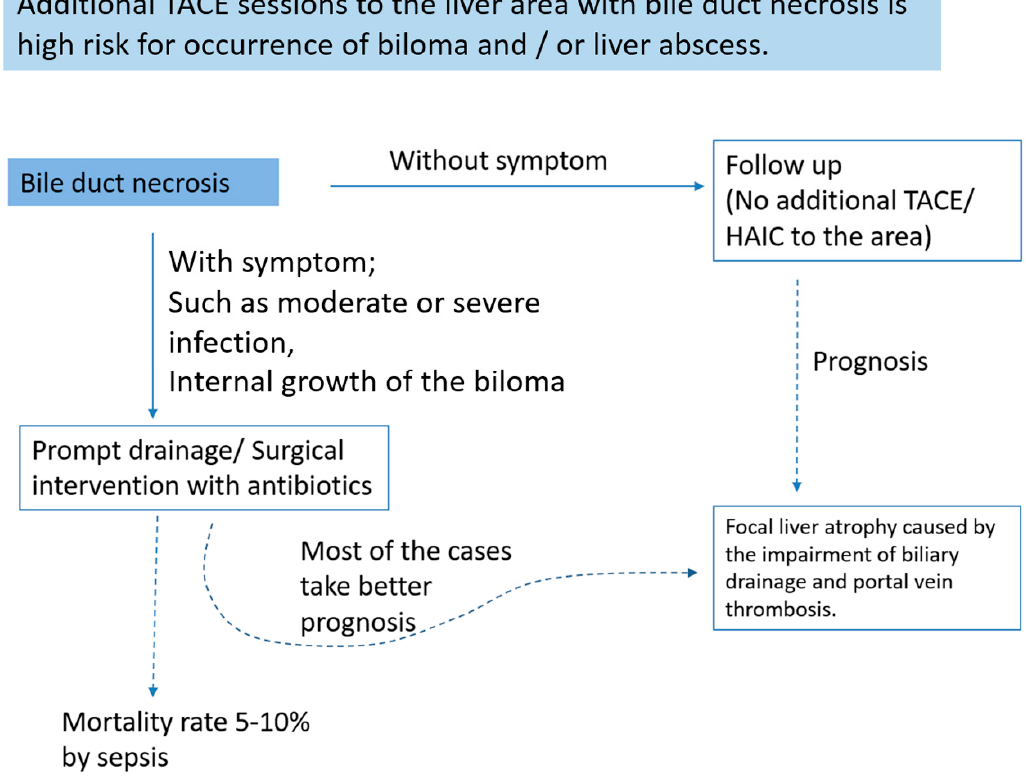
Figure 22. Schematic diagram of the treatment strategy for BDN.